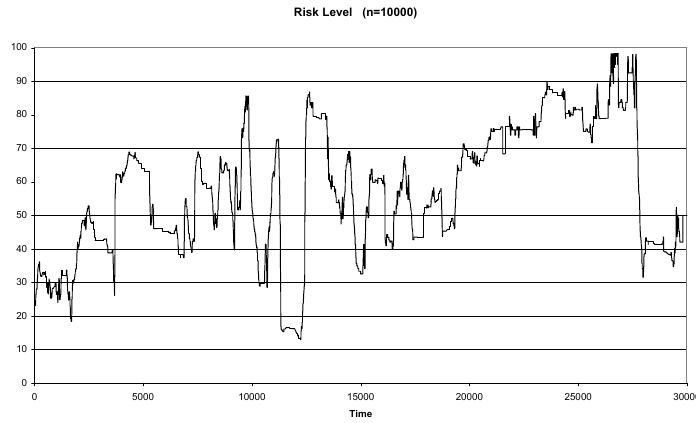
Figure 5. Risk level for the fusion of experts (n =